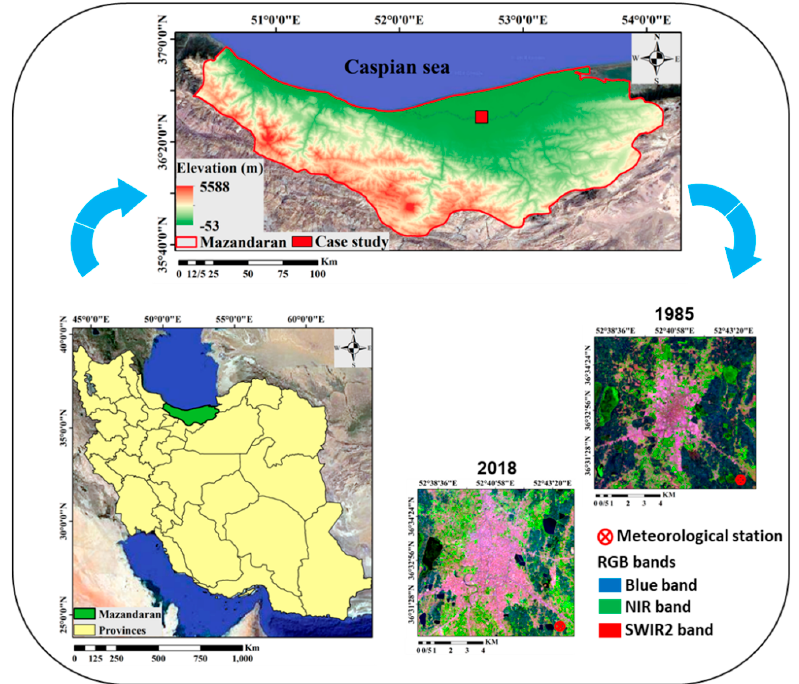
Figure 1. Location of the study